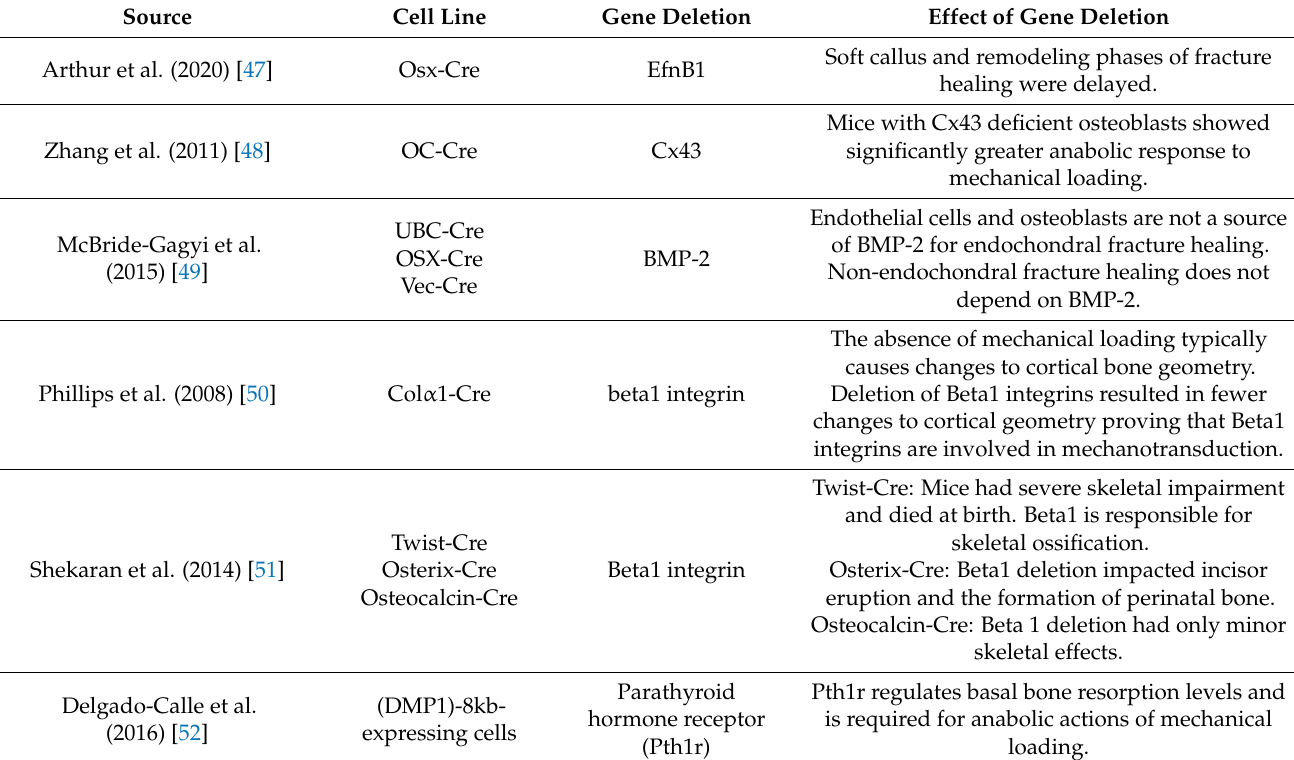
Table 1. Effects of Cell Type Specific Gene Deletions on the Response of Cells to Mechanical Loading.